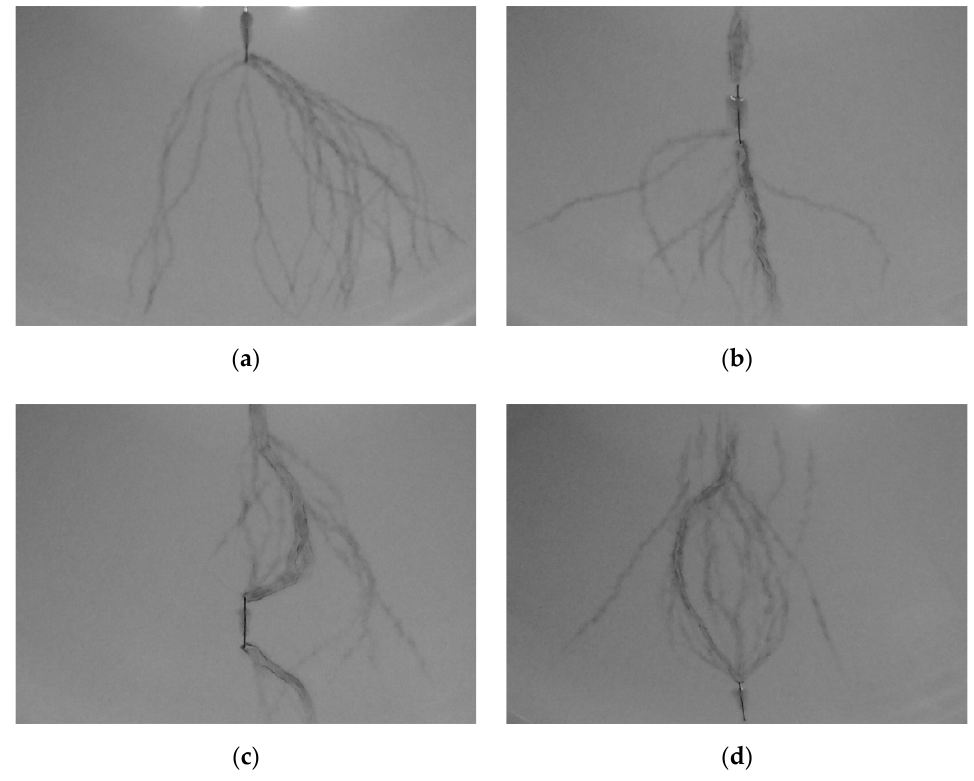
Figure 7. Gray ‐ level tracking image applied in calculating FD with particle at various locations. Each sub ‐ figure has been flatted and is in accordance with the images in Figure 6. In ( a ), the particle is located at 19 mm. In ( b ), the particle is located at 71 mm. In ( c ), the particle is located at 123 mm. And in ( d ), the particle is located at 175 mm from HV electrode.